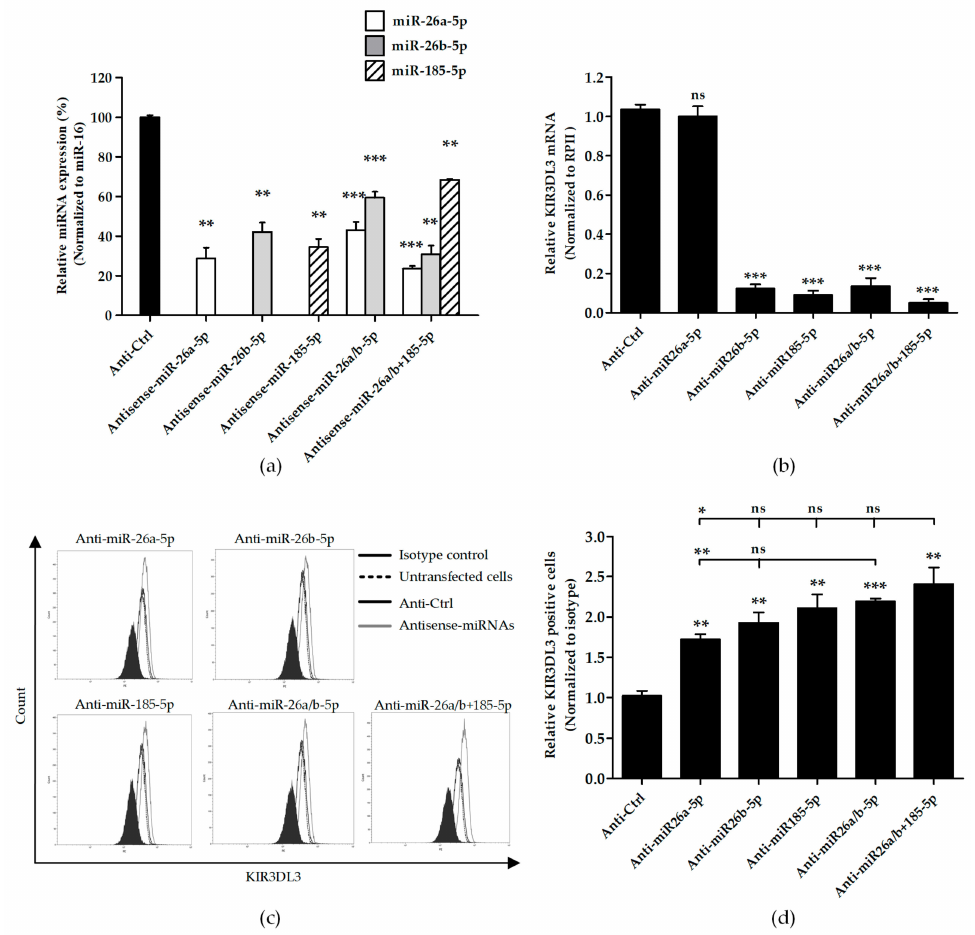
Figure 3. Knockdown candidate miRNAs increase the expression of KIR3DL3. K562 cells were transfected with 500 nM candidate antisense miRNAs for 48 h and subsequently assessed for KIR3DL3 expression. ( a ) Relative expression levels of mature miR-26a-5p, -26b-5p and 185-5p normalized to miR-16 when were compared to the anti-sense control (scramble) are presented. ( b ) The relative KIR3DL3 mRNA expressions are presented. Total RNA was extracted, and the levels of KIR3DL3 mRNA normalized to RPII were measured by RT-PCR. The figure shows the means ± S.E.M. from three independent experiments. ( c ) After transient transfection, cells were examined by flow cytometry for cell surface KIR3DL3 expression. The filled histogram represents cells stained with the isotype antibody. In the open histogram, the dotted line indicates K562 untransfected cells, the solid line shows the data from the negative control (anti-Ctrl or miRNA scramble control) and the gray line represents the transfection of 500 nM antisense miRNAs all stained with the KIR3DL3 antibody. ( d ) A relative number of positive cells for KIR3DL3 are shown. Results are calculated from three experiments and depicted as mean ± S.E.M. *, p < 0.05; **, p < 0.01; ***, p <